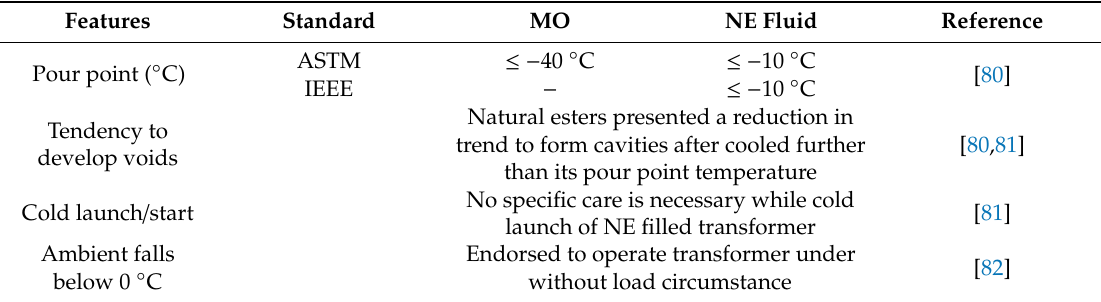
Table 9. Pour points of various insulating